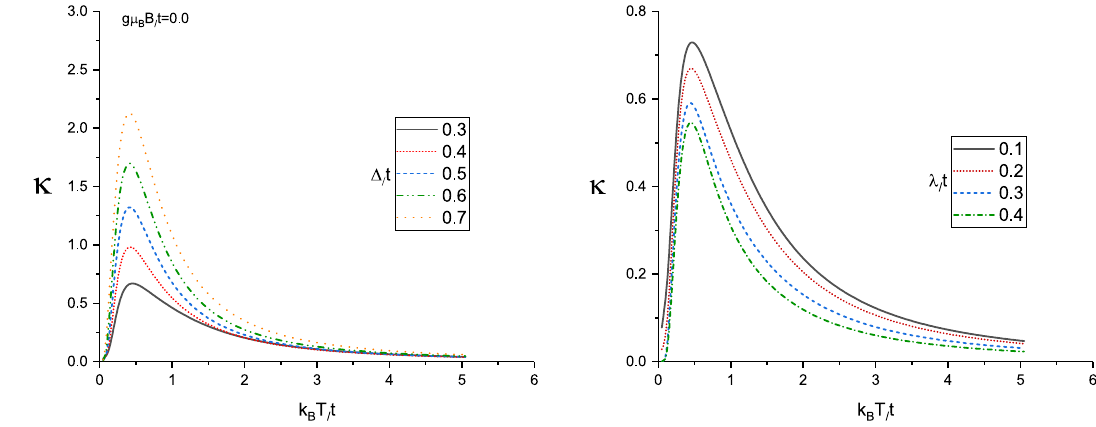
Figure 2. Left Panel: Thermal conductivity of Lieb lattice as a function of normalized temperature k B T / t for different values of normalized gap parameter �/ t in the absence of magnetic field. Normalized chemical potential and normalized spin-orbit coupling have been fixed at µ/ t = 1.0 and (cid:31) / t = 0.2 , respectively. Right Panel: Thermal conductivity of Lieb lattice as a function of normalized temperature k B T / t for different values of normalized spin-orbit coupling (cid:31) / t in the absence of magnetic field. Normalized chemical potential and normalized gap parameter have been fixed at µ/ t = 1.0 and �/ t = 0.3 ,